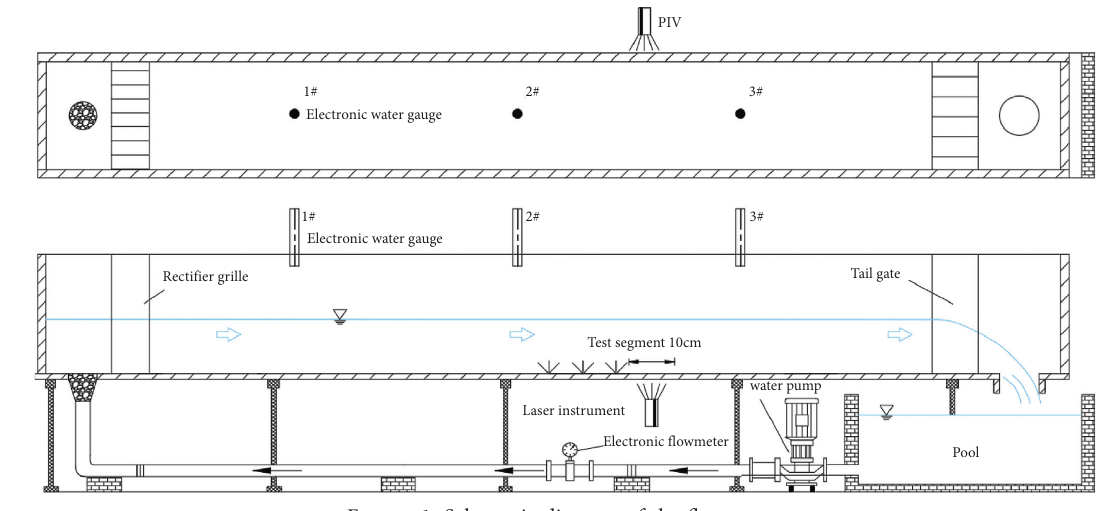
Figure 1: Schematic diagram of the flume test. Table 1: Test conditions and related parameters.